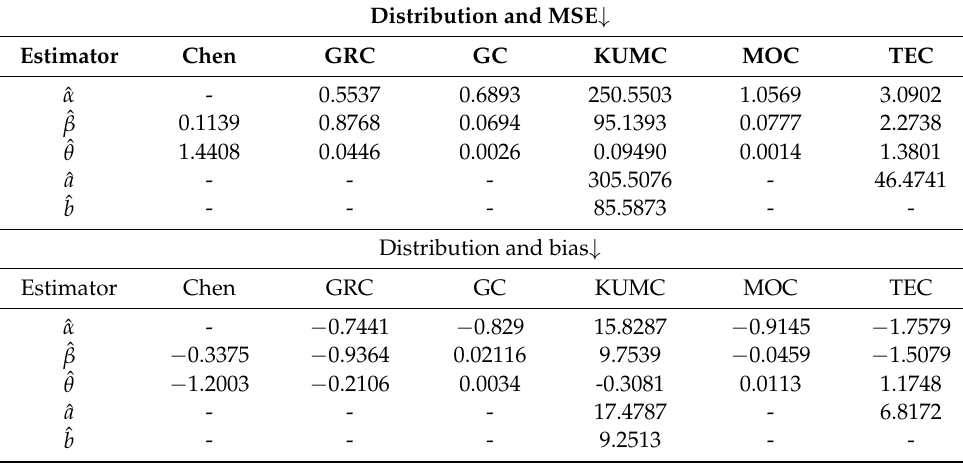
Table 10. Results for samples generated from the Chen distribution with n = 200.